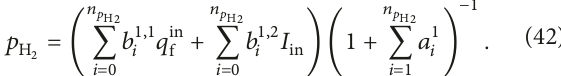
Table 4: Parameters of the reduced-order hydrogen pressure model of order 𝑛 𝑝 𝑛 𝑝 H 2